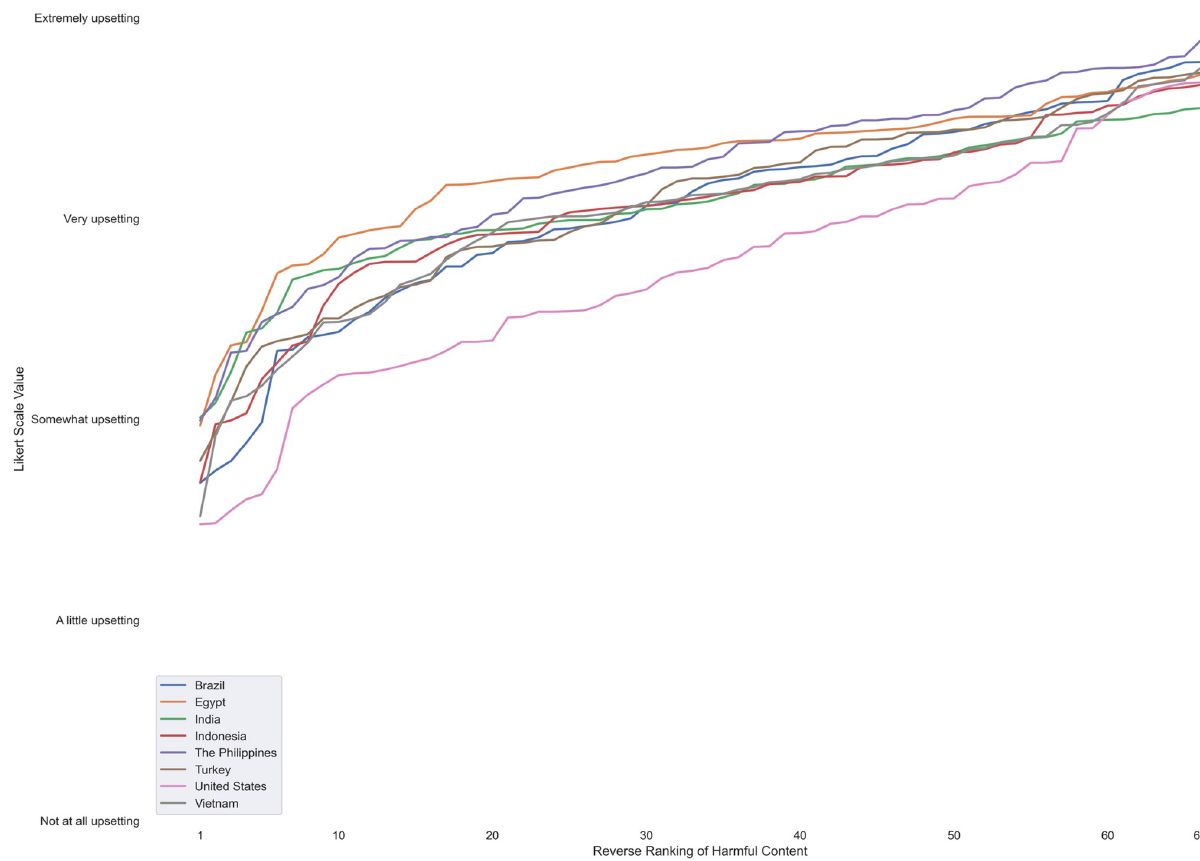
Fig 2. Plot of severity value vs. reverse severity rank order for each country under a Likert-scale measurement.